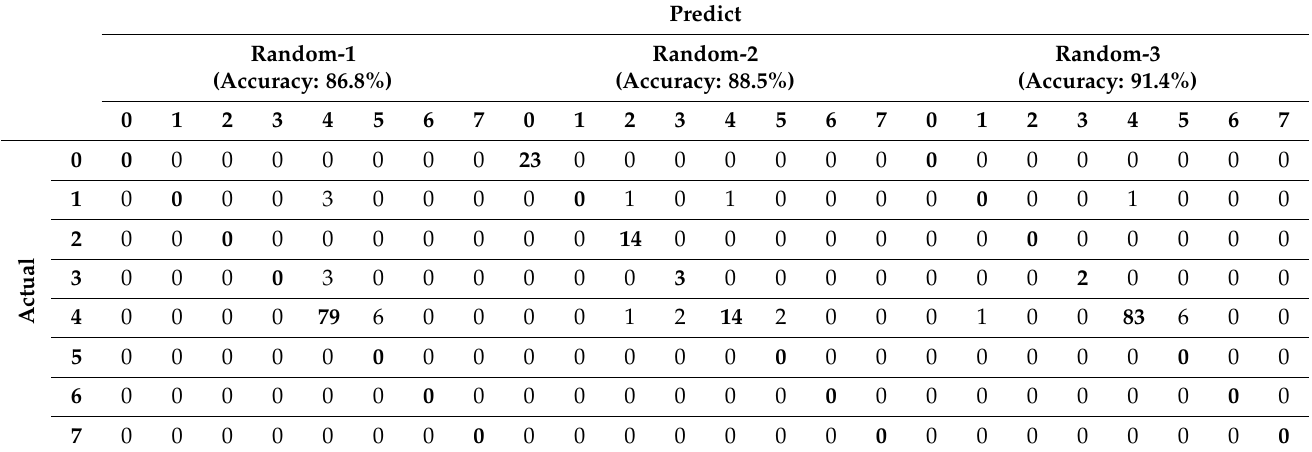
Table 10. Confusion matrix for Room 3 Sequence 11 (with median